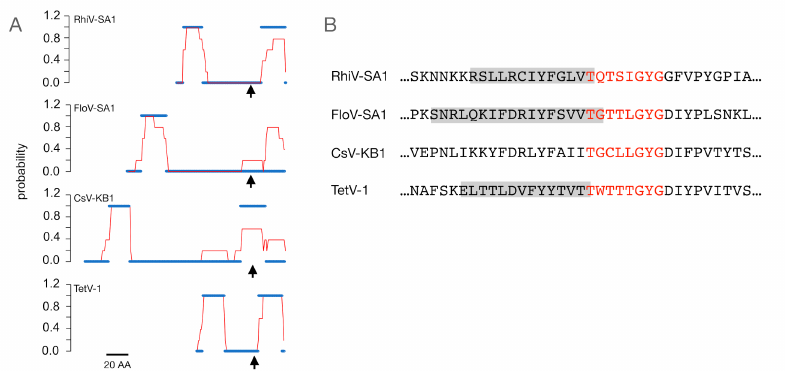
Figure 4. Structural predictions for putative K + channel proteins. ( A ) Probability for transmembrane domains in four putative K + channel sequences. The amino acid sequences from Figure 1 were analyzed with five di ff erent algorithms for predicting transmembrane domains. The red line shows the prediction by TMHMM and the blue line represents the mean of all predictions. For calculating the mean value, each amino acid which was predicted to be part of a transmembrane domain was set to 1 and all others to 0. The results are aligned to the position of the first glycine in the first G in the GYG motif (arrow). ( B ) Prediction of α -helices with the JPred algorithm. The grey bars indicate the predicted location of an α -helix upstream of the selectivity filter sequence (red) in 3 of the 4 sequences.